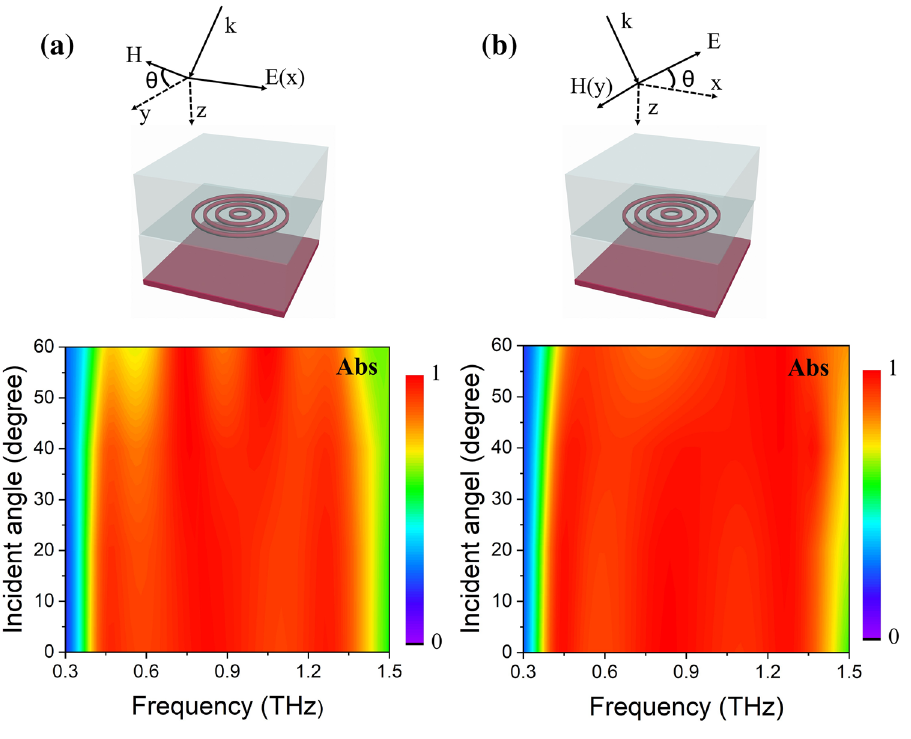
Figure 6. Absorption (Abs) spectra in ( a ) TE and ( b ) TM polarization states as function of incident angle.